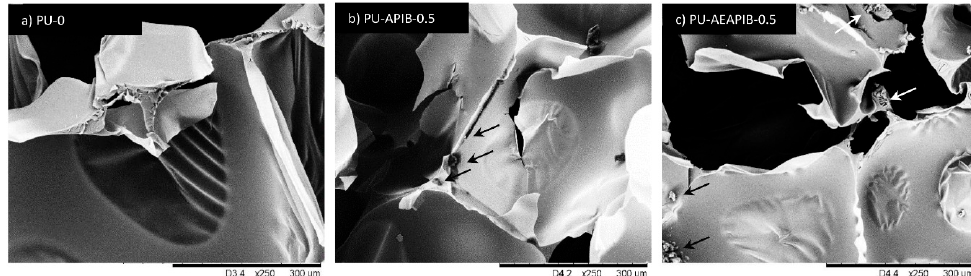
Figure 6. Morphology of ( a ) PU-0, ( b ) PU-APIB-0.5 and ( c ) PU-AEAPIB-0.5 observed at the same magnification.